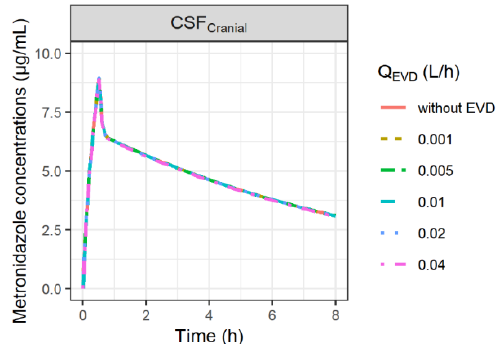
Figure 4. Simulation of the impact of external ventricular drain flow (Q EVD ) on CSF concentrations of metronidazole. Q EVD was assumed to be constant over time and to restore the physiological CSF out- flow (Q sink ). Thus, when Q EVD was higher than the physiological value of Q sink (Q EVD > 0.024 L/h), Q sink was set at 0 L/h.